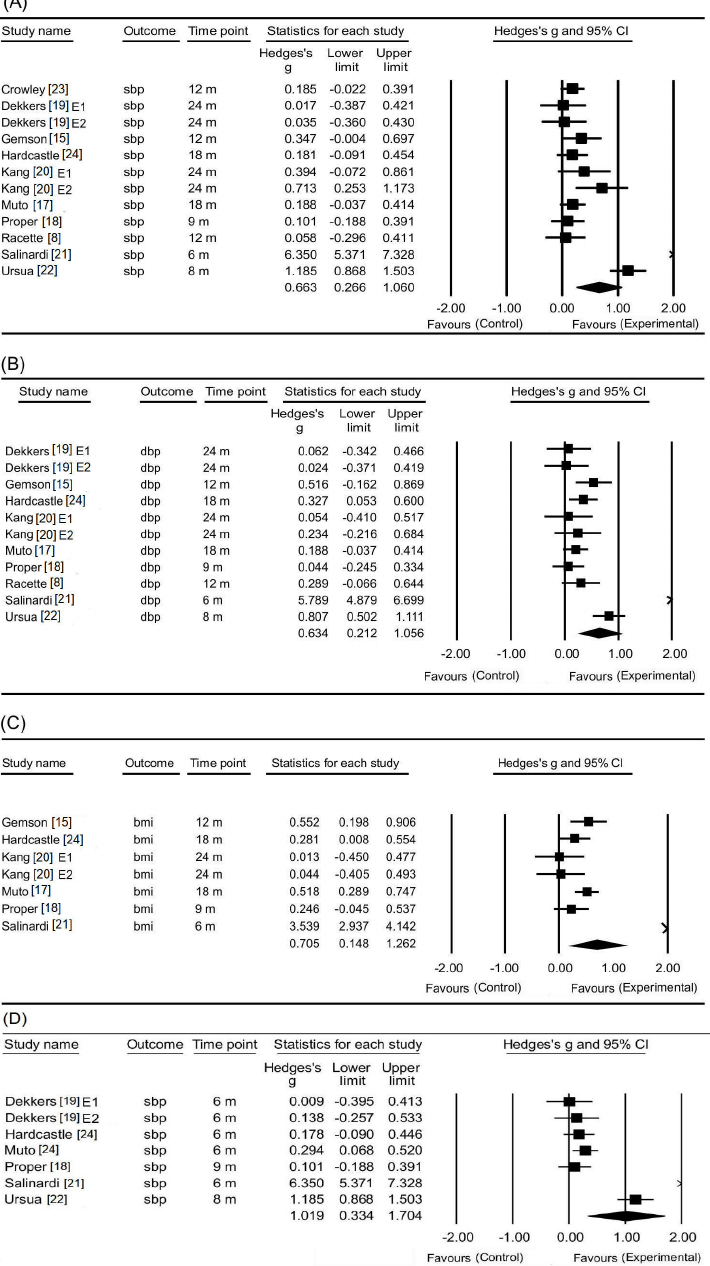
Figure 2. The effect of the intervention. ( A ) Systolic blood pressure at final point; ( B ) Diastolic blood pressure at final point; ( C ) BMI at final point; ( D )The effect of the intervention on systolic blood pressure < 12 m; E1=Experimental group 1; E2=Experimental group 2.